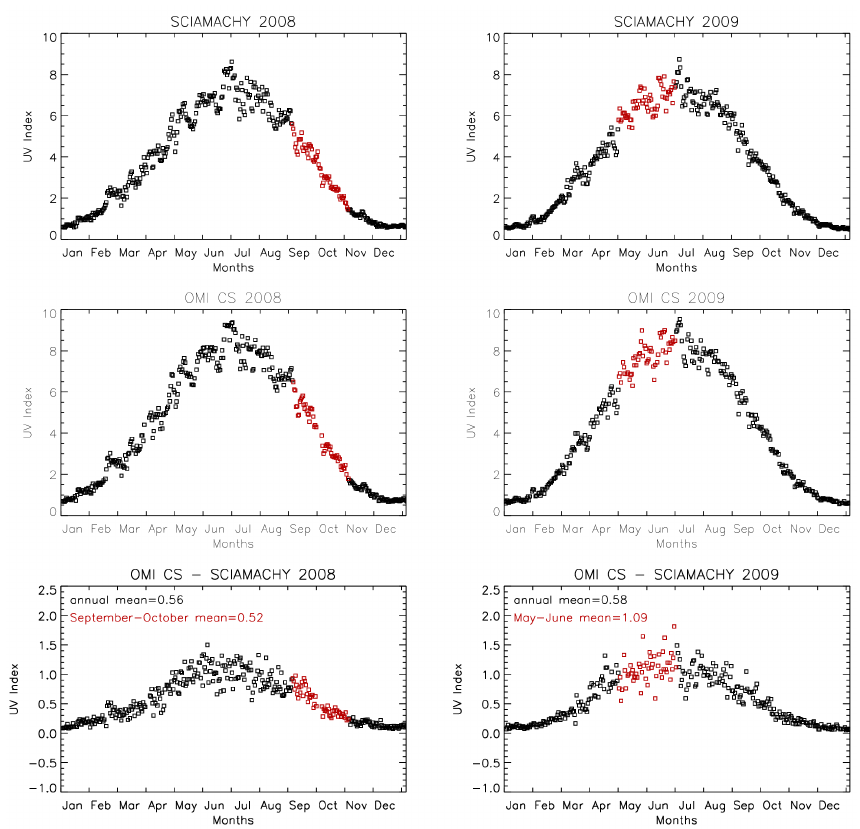
Fig. 2. SCIAMACHY and OMI (clear-sky data) satellite 2008 (left) and 2009 (right) UVI products. Bottom figures: absolute mean difference between OMI clear sky and SCIAMACHY products for 2008 (left) and 2009 (right). Red squares: RISC UV campaign